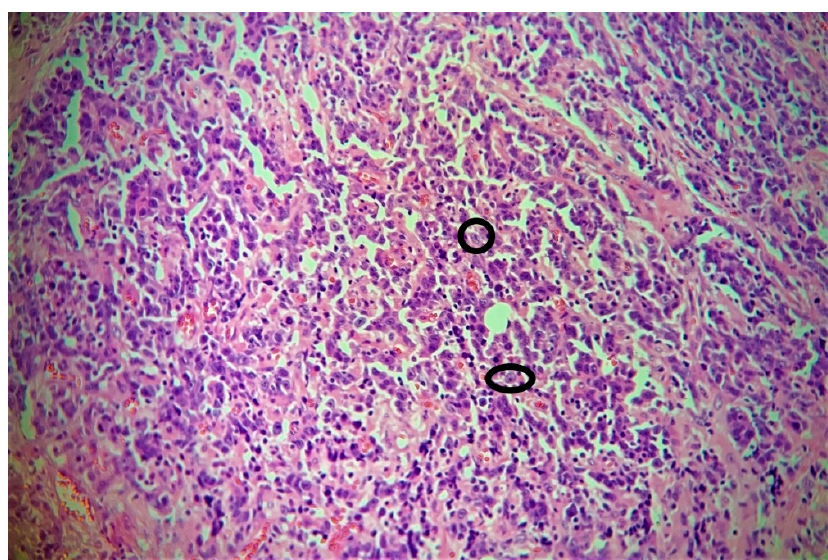
Figure 8. Clear cell nuclei, along with prominent nucleoli, are demonstrated. Dense lymphocytic infiltration is also seen in the background.